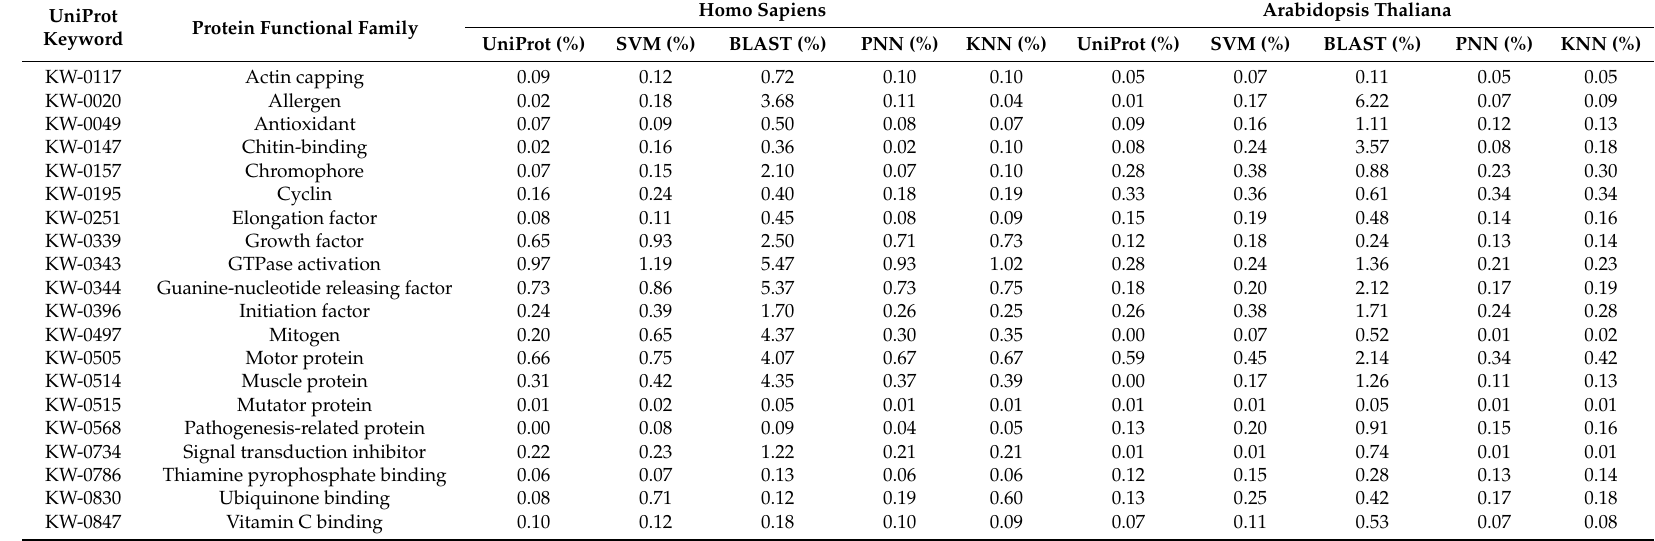
Table 2. The false discovery rate assessed by the percentage of proteins identified from human and thaliana genomes by different algorithms. UniProt